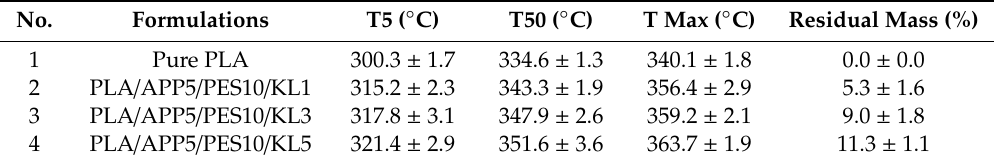
Figure 4. Thermogravimetric curves of bicomponent fibers. Table 6. Data of thermogravimetric